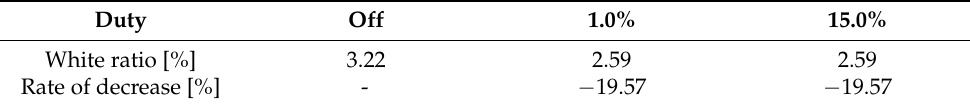
Table 4. Snow accumulation test (arc model)